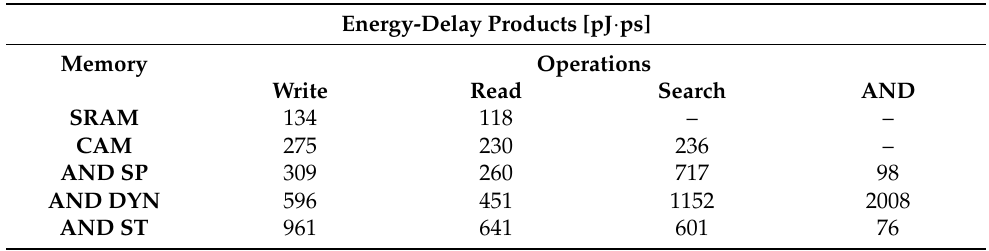
Figure 19. The energy-delay product associated to each memory operation in each array, for different values of the memory size. Table 3. The energy-products associated to each memory operation, for each memory array. Data are extracted from the 256 × 256 array of Figure 19, which is used as case